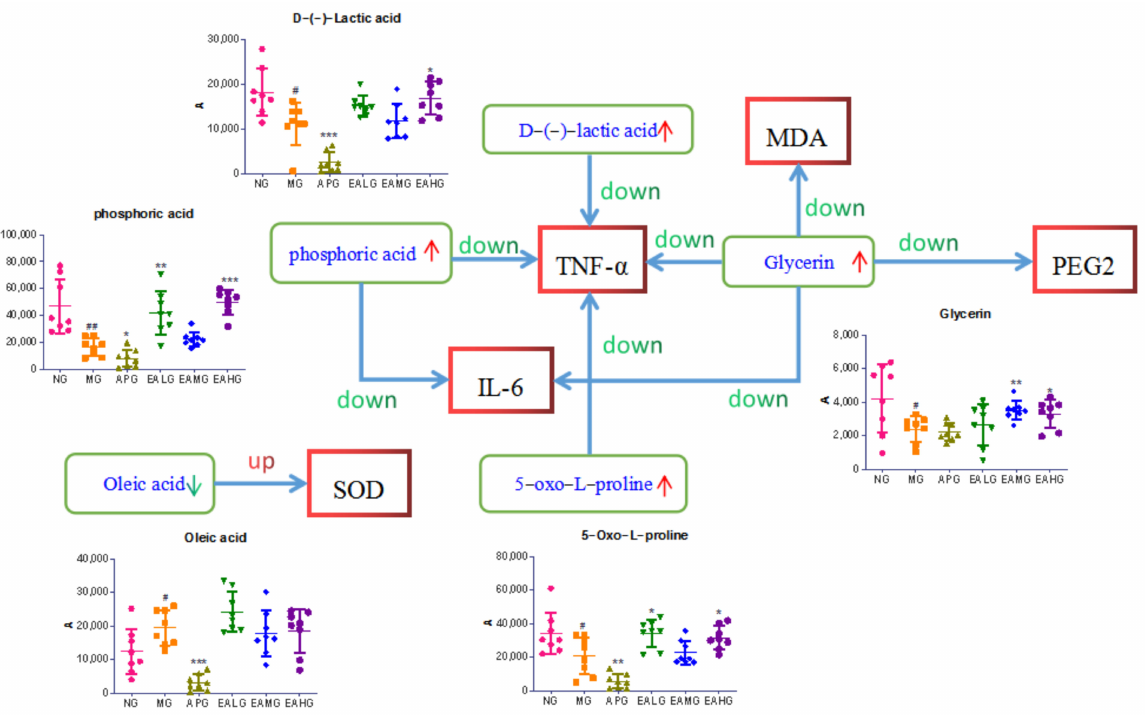
Figure 10. Potential target metabolic pathway of EA in the treatment of fever in rats. The green box shows the differential metabolites, ↑ level up, ↓ level down; The red box shows the regulated inflammatory factors. # p < 0.05, ## p < 0.01 vs. NG; * p < 0.05, ** p < 0.01, *** p < 0.001 vs.